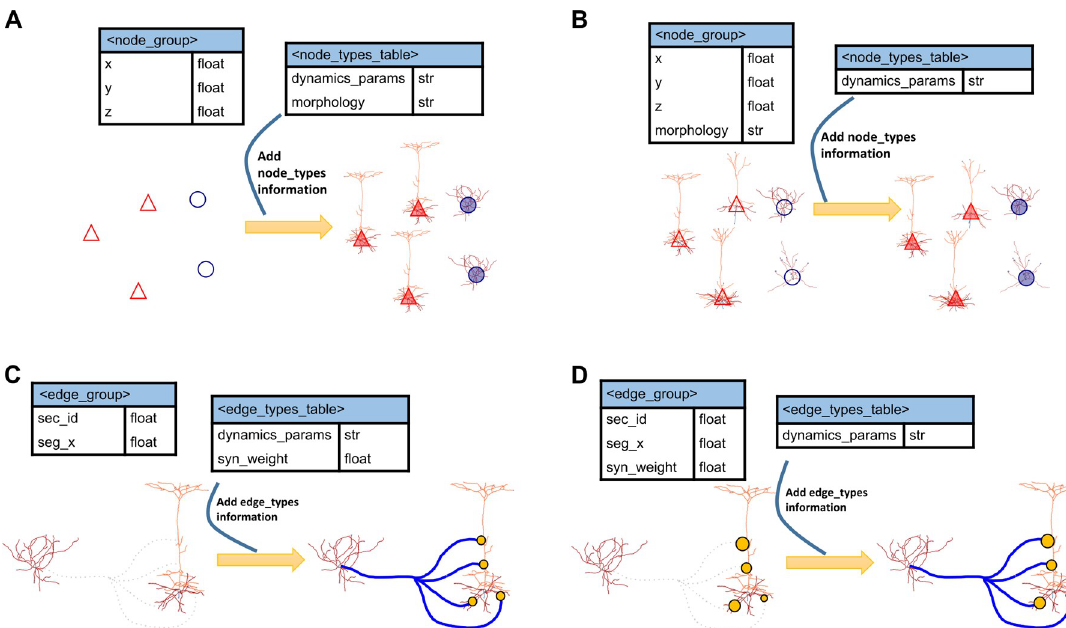
Fig 2. Nodes and edges in SONATA format. (A, B) Two examples are shown that demonstrate how for each node one can find its model attributes in either the node_group (for individually unique attributes) or the node_types table (for globally shared attributes). In (A), the unique attributes are only the node locations (x, y, z), indicated by empty triangles and circles on the left. Morphology and dynamic parameters are shared among multiple nodes within a type. Hence, all red triangles share the same morphology, as do blue circles (right). In (B), the morphology is unique for each node. The dynamics_params is the only attribute specified at the type level; it is assigned to each node, as indicated by the triangles and circles being filled with color on the right. (C, D) Same for edges. In (C), the synaptic locations are stored individually for each edge, whereas synaptic weights and dynamics_params attributes are stored at the edge type level, as indicated by the uniform circle size and colored connections on the right (“dynamics_params” attributes here determine the dynamical properties of synapses, such as the time of rise and time of decay of synaptic conductance). (D) The synaptic locations as well as synaptic weights are stored individually (hence different circle sizes), whereas the dynamics_params attributes are stored at the edge type